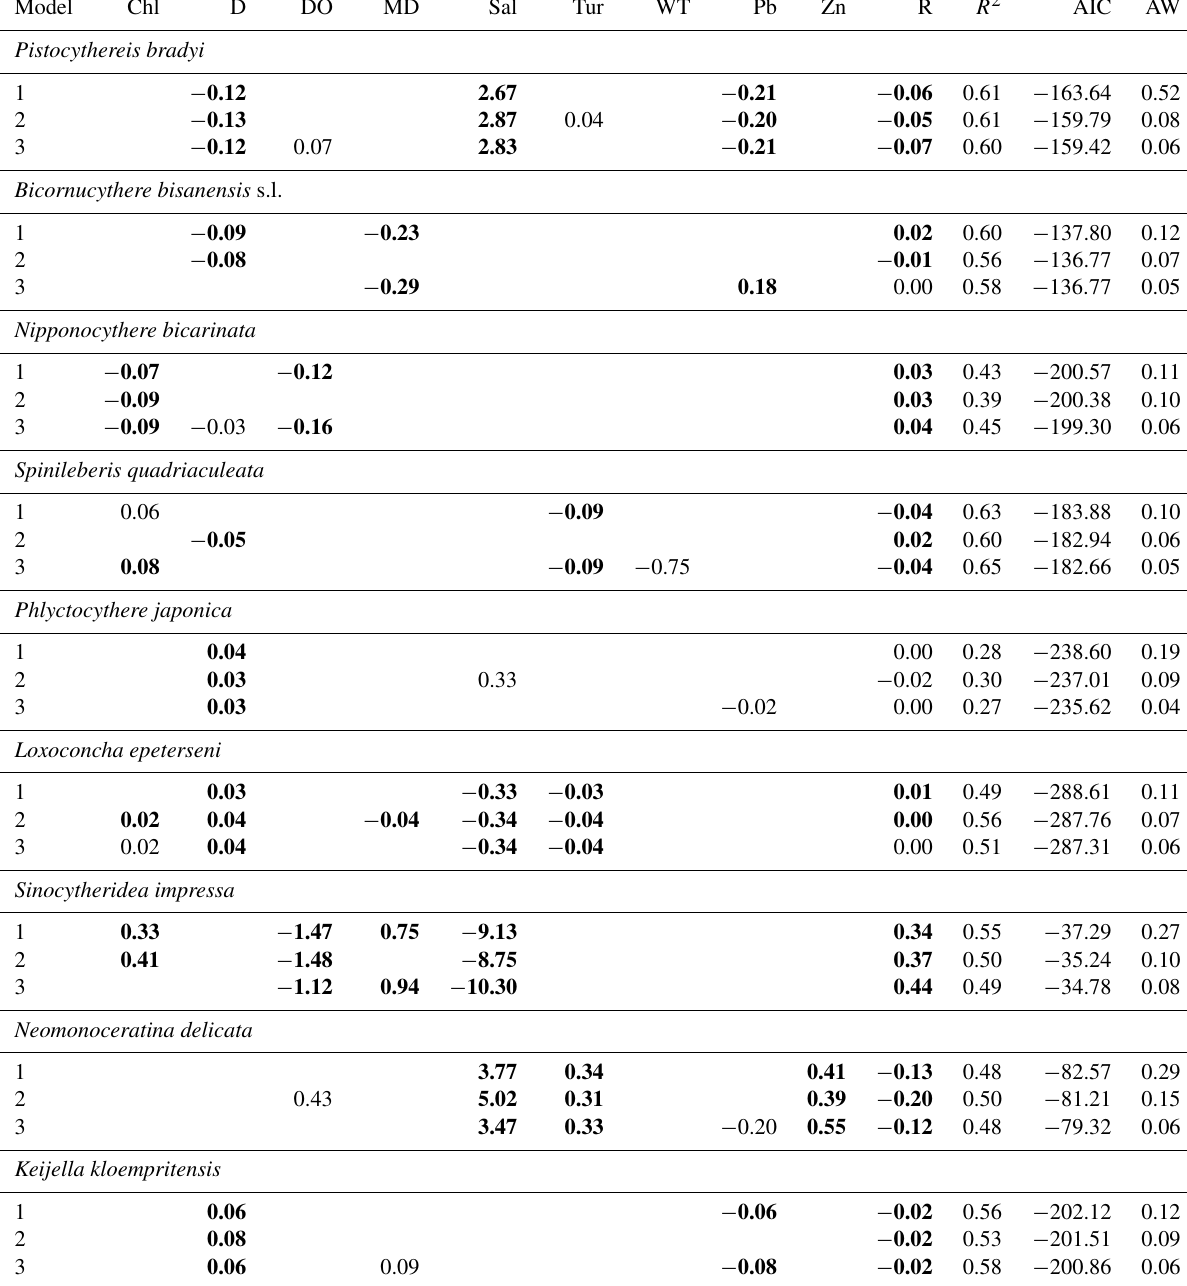
Table 2. Best three regression models of the relative abundance of common species, including Pistocythereis bradyi , Bicornucythere bisanen- sis s.l., Nipponocythere bicarinata , Spinileberis quadriaculeata , Phlyctocythere japonica , Loxoconcha epeterseni , Sinocytheridea impressa , Neomonoceratina delicata , Keijella kloempritensis , Neosinocythere elongata , Stigmatocythere roesmani , Hemicytheridea reticulata , Loxo- concha malayensis , Alocopocythere goujoni , Hemikrithe orientalis , Propontocypris spp., Neonesidea spp., and Xestoleberis spp. The table shows the coefficient of each term, adjusted R 2 , the Akaike information criterion corrected for small sample size (AIC), and the Akaike weight (AW). Bold denotes significance at P < 0 . 05. Overall, P is < 0.05 in all models. R: region. Other abbreviations are found in Table